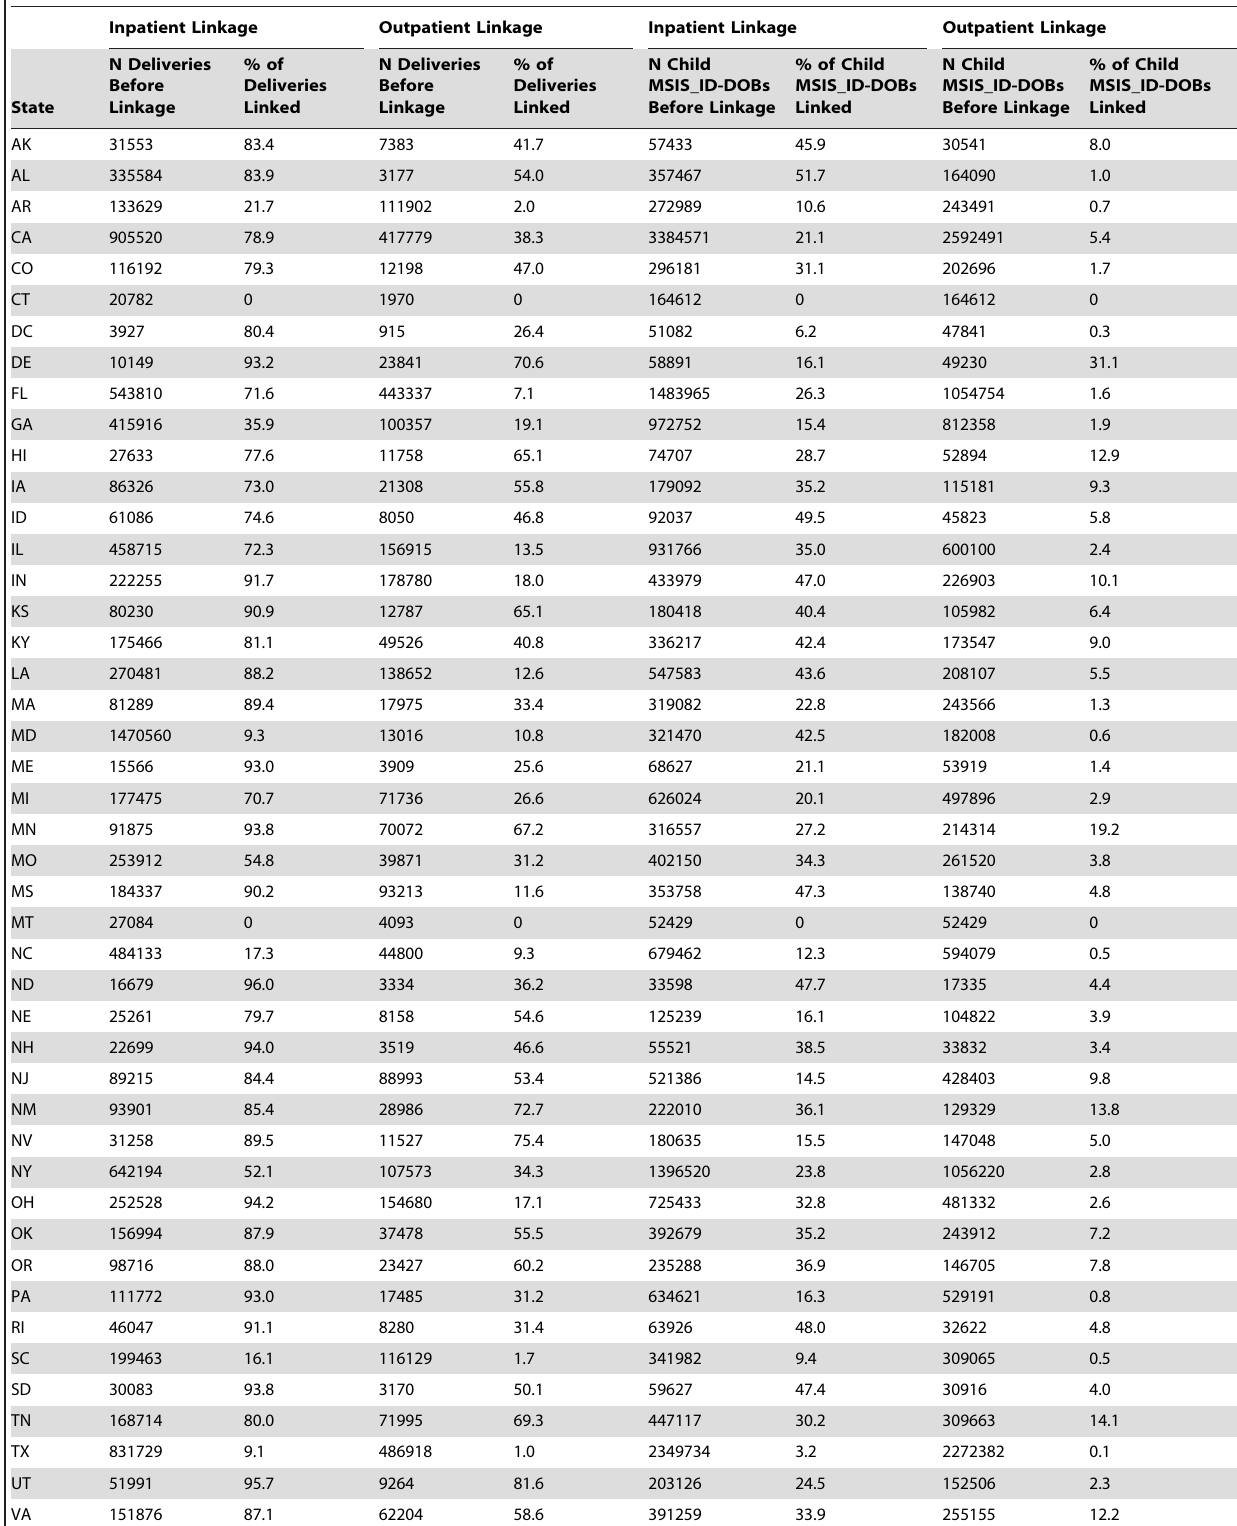
Table 1. The number of deliveries before linkage and the percentage of deliveries that linked to an infant, and the number of child MSIS_ID and date of birth combinations before linkage and the percentage of combinations that linked to a delivery listed by inpatient and outpatient linkage and by state; Medicaid Analytic eXtract,